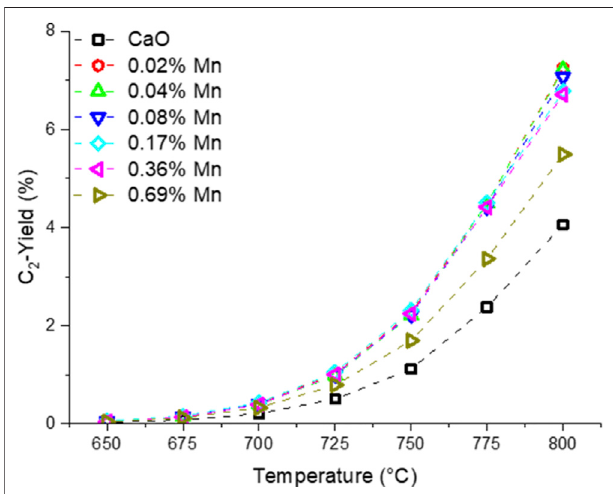
FIGURE9| Temperaturedependenceofcombinedethaneandethylene yield of manganese doped CaO catalysts (50 mg carbonate precursor,